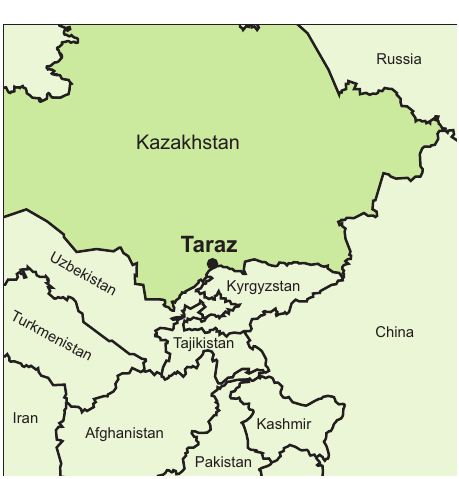
Fig. 1: Location of Taraz in Central